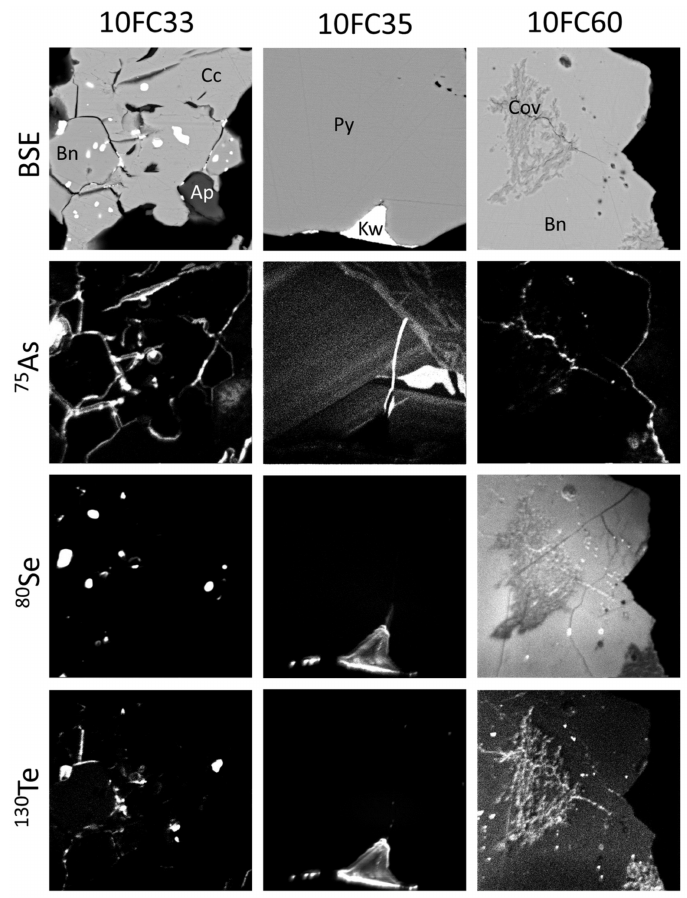
Figure 10. The BSE (top row) and nanoSIMS images of potentially deleterious elements ( 75 As, 80 Se, and 130 Te) in di ff erent assemblages from three sulfide flotation concentrate (FC) samples. Abbreviations: Ap-apatite; Bn-bornite; Cc-chalcocite; Cov-covellite; Kw-kawazulite; Py-pyrite. Zoning with respect to As is evident in sample